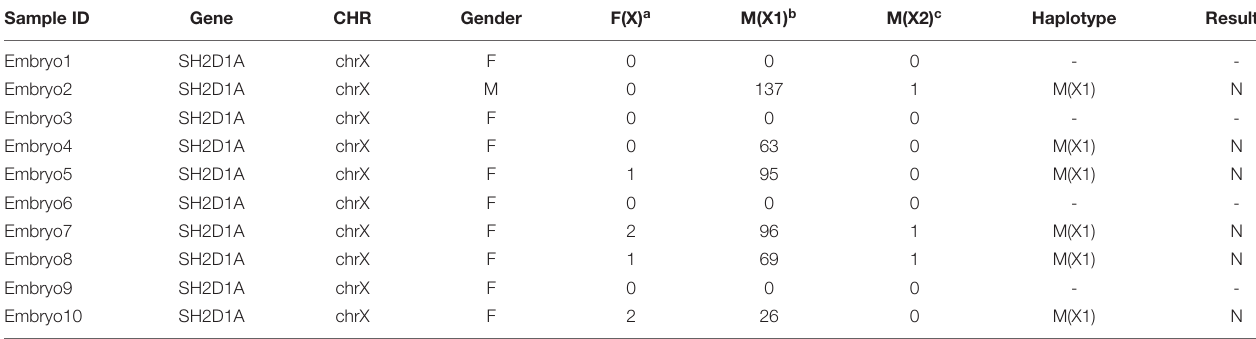
CHR, chromosomes; F(X), X chromosome from father; M(X1), X chromosome without pathogenic mutations from mother; M(X2), X chromosome with pathogenic mutations from